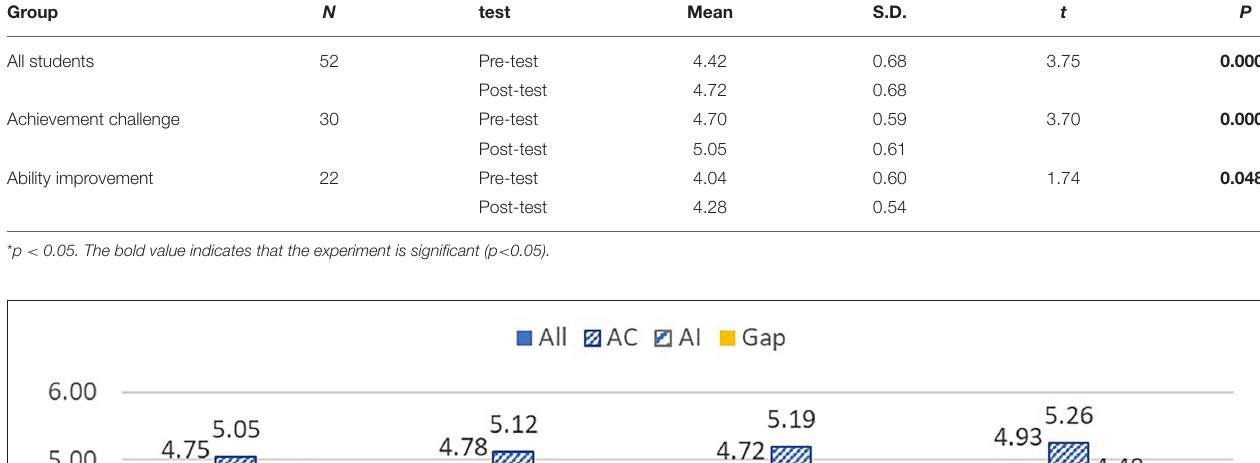
TABLE 2 | Paired t -test result of the learning motivation. Group